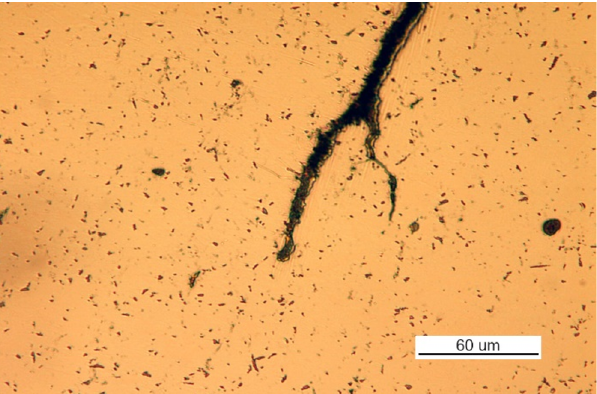
Figure 20. The crack front. Non-etched metallographic specimen (handy-size bulk carrier 30206 DWT). Optical microscopy.